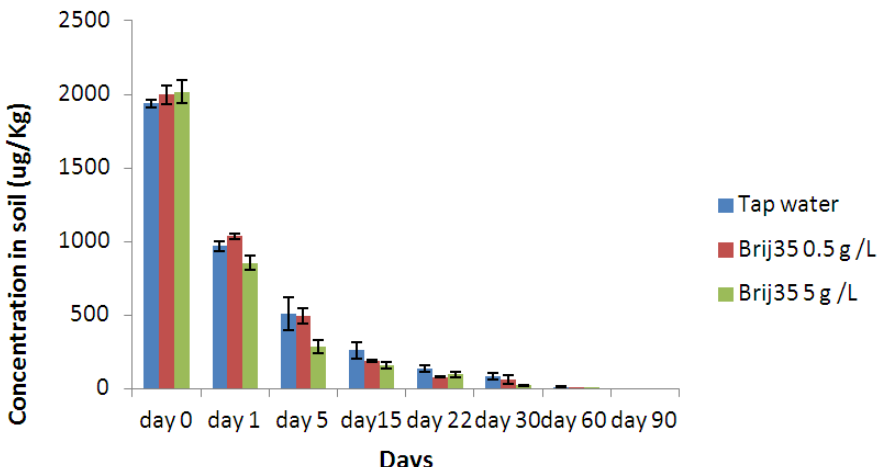
Figure 4. Metribuzin concentrations at the surface.